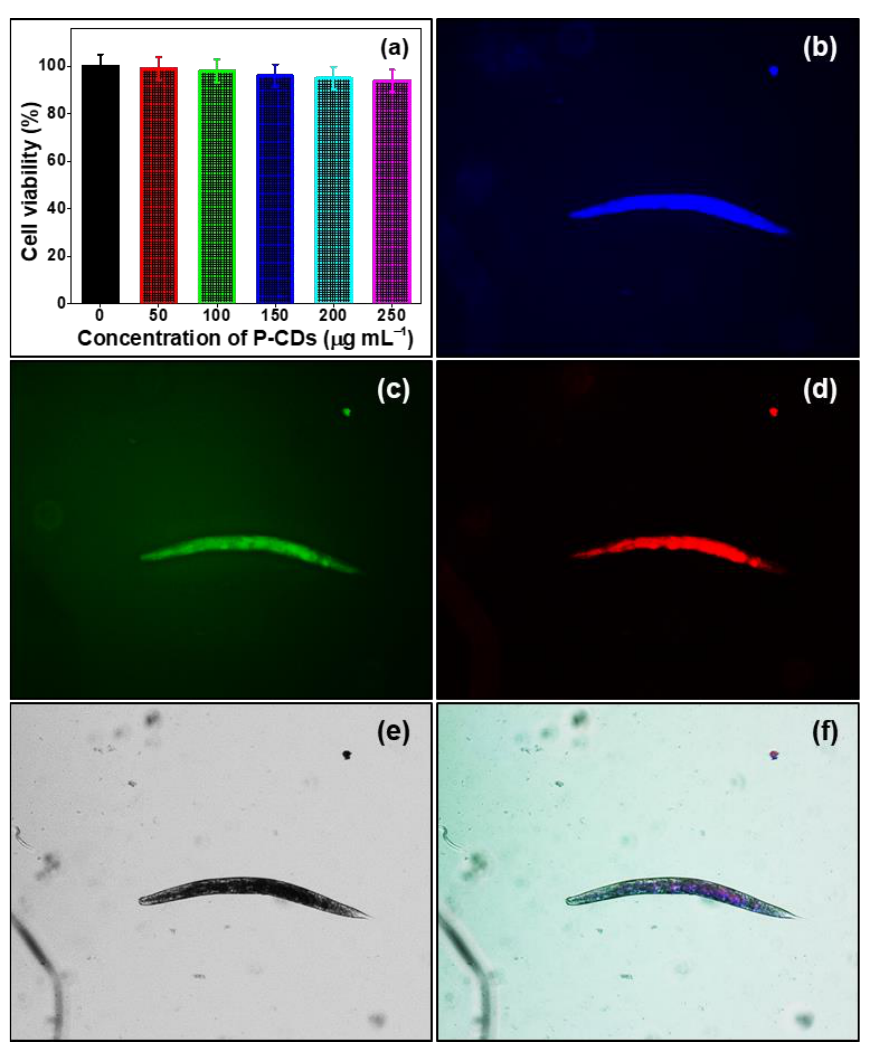
Figure 7. ( a ) Cell viability values (%) estimated by MTT assay versus incubation concentrations of P-CDs (0, 50, 100, 150, 200 and 250 µ g mL − 1 ) at 25 ◦ C for 48 h. The confocal fluorescence microscopy images of nematodes (Caenorhabditis elegans) treated with 100 μg mL − 1 P-CDs for 24 h under excitation of ( b ) 400 nm, ( c ) 470 nm, ( d ) 550 nm, ( e ) bright-field and ( f ) overlap. Live Caenorhabditis elegans were immobilized using 0.05% NaN 3 for imaging under fluorescence filters.